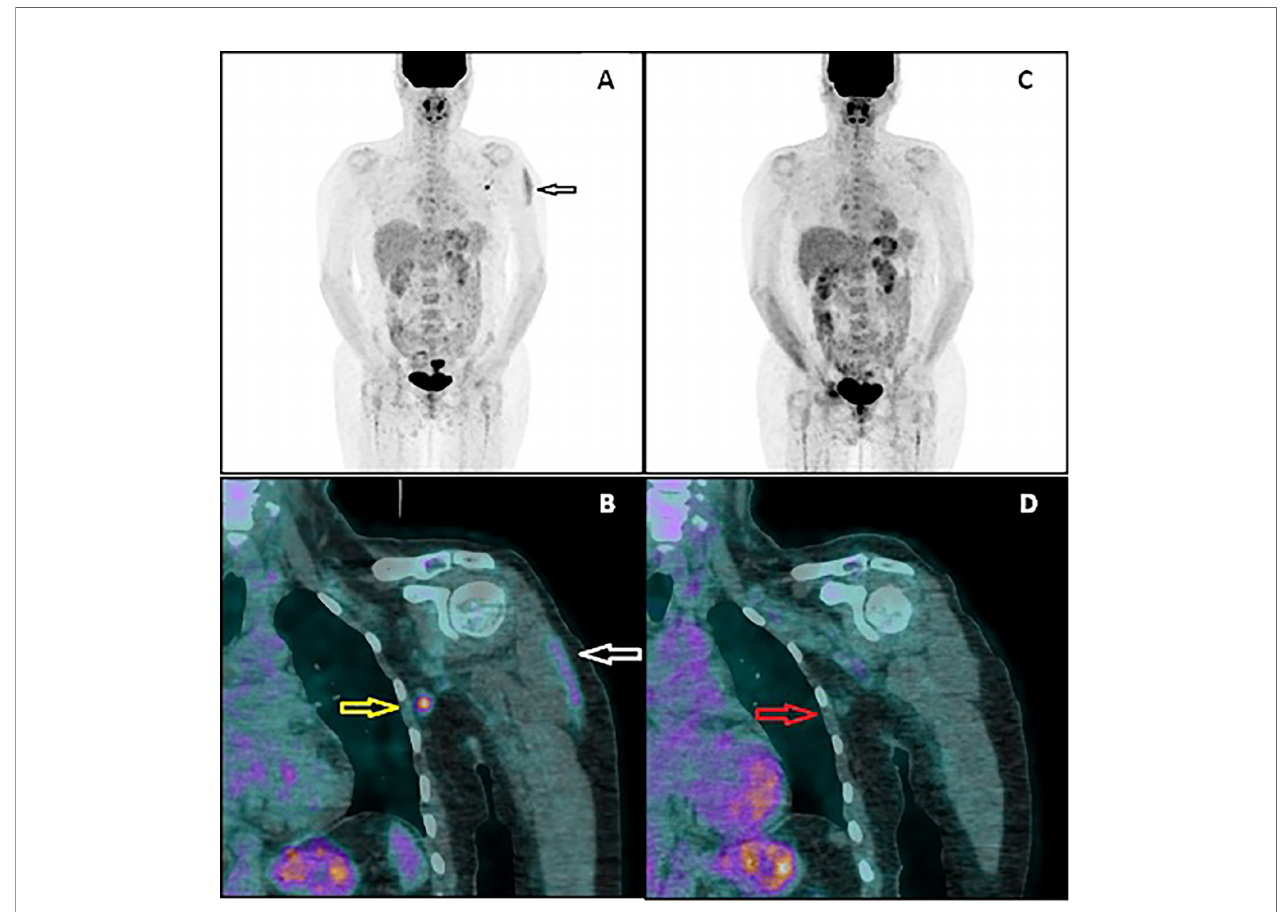
FIGURE 2 | PET/CT image performed 4 days after vaccination (A, B) . The multiple-intensity projection image (A) showing increased 18 F-FDG uptake in the left deltoid muscle (black arrow) and in the left axillary region. Fused coronal image (B) showing the uptake in the muscle (white arrow) and in the axillary lymph node (yellow arrow). PET/CT image performed 32 days after vaccination (C, D) . Both the muscular uptake and nodal uptake have disappeared. The referred axillary lymph node (red arrow) shows similar morphology but no 18 F-FDG